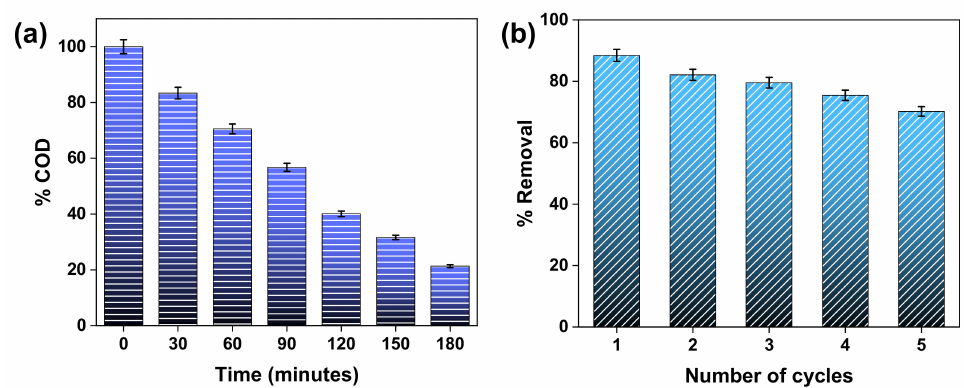
Figure 8. ( a )CODremoval; ( b )reusabilityofGA-cl-poly(acrylamide)@C 3 N 4